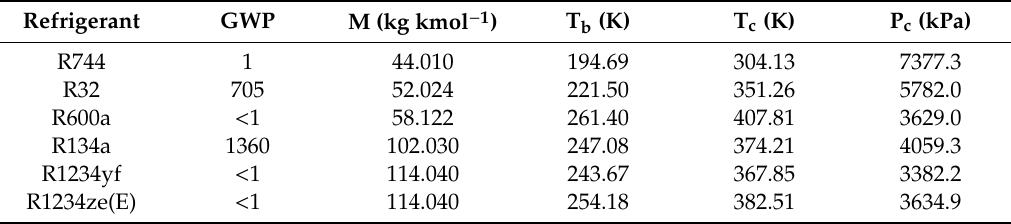
Table 1. Global Warming Potential (GWP) and physical properties of the studied